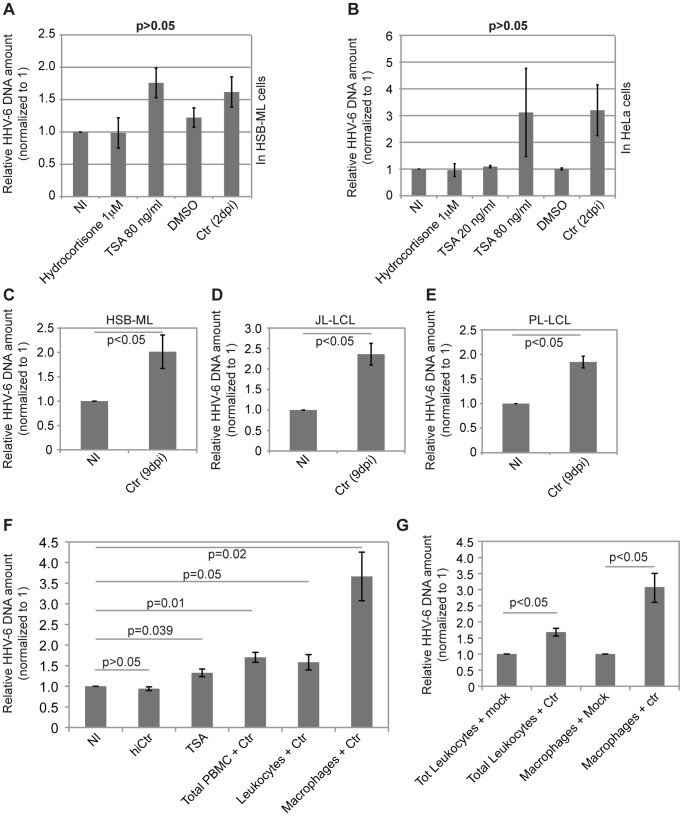

Chlamydia trachomatis infection induces CiHHV-6 DNA replication.(A) qPCR analysis of viral DNA in HSB-ML cells after 2 days of C. trachomatis infection. HSB-ML cells were infected with C. trachomatis (Ctr) for 2 days. In parallel, the same number of HSB-ML cells was cultured in the presence of 1 µM hydrocortisone or 80 ng/ml of TSA for 2 days. As TSA was dissolved in DMSO, a DMSO control was also included in the study. Data represent the mean ± SEM of 5 independent experiments. (B) qPCR analysis of viral DNA in HeLa cells carrying latent HHV-6A after 2 days of C. trachomatis infection. Cells were infected with C. trachomatis or were treated with TSA or hydrocortisone as mentioned in (A). Data represent the mean ± SEM of 5 independent experiments. (C, D, E) qPCR analysis of viral DNA in HSB-ML (C), JL-LCL (D) and PL-LCL (E) cells after 9 days of C. trachomatis infection. Cells were infected with C. trachomatis at an MOI of 2–5 for 2 days after which cells were washed thoroughly and grown in presence of fresh media with 1 µg/ml of doxycycline for another 7 days. Total DNA was isolated and used for qPCR assay. Data represent the mean ± SEM of three independent experiments. (F) qPCR analysis of viral DNA in freshly isolated blood cells from CiHHV-6 individuals after 5 days of C. trachomatis infection. Fresh PBMCs were isolated from total blood and were infected with C. trachomatis for 2 days at an MOI of 5 after which cells were washed thoroughly and grown in presence of fresh media with 1 µg/ml of doxycycline for another 3 days. In parallel, the same numbers of PBMCs were cultured in presence of 80 ng/ml of TSA for 5 days. Total leukocytes were separated from monocyte-derived macrophages and were infected with C. trachomatis in parallel. Heat inactivated C. trachomatis (hiCtr) were added to total PBMCs in a separate well and were included as negative control. Data represent the mean ± SEM of results from blood samples of 5 different CiHHV-6 individuals. (G) qPCR analysis of viral DNA in total leukocytes and monocyte-derived macrophages from CiHHV-6 individuals after 5 days of C. trachomatis infection. Total leukocytes were separated from monocyte-derived macrophages and were infected with C. trachomatis for 2 days at an MOI of 5 after which cells were washed thoroughly and grown in presence of fresh media with 1 µg/ml of doxycycline for another 3 days. Data represent the mean ± SEM of three independent experiments performed at the same time from one CiHHV-6 individual.